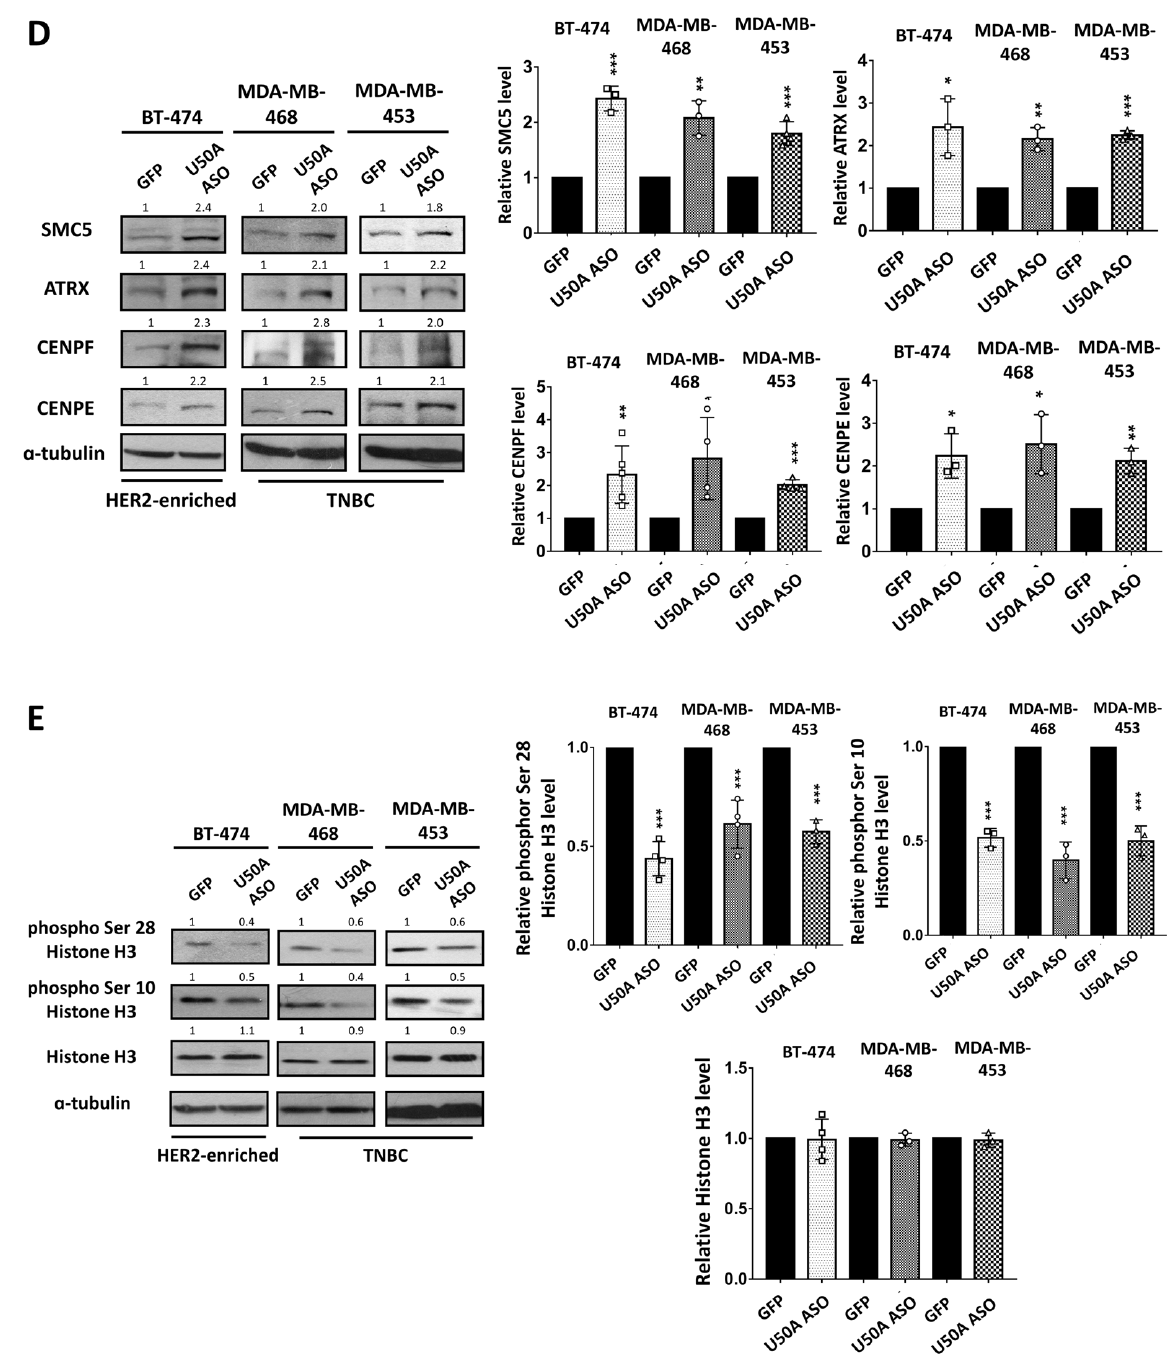
Figure 3. Mitosis-related genes regulated by U50A. ( A ) Validated fold change of CENPE/F, ATRX, and SMC5 in U50A- overexpressing MCF-7 cells. Data are represented as the mean ± SD ( n ≥ 3). *** p < 0.001. Protein expression of the selected targets in U50A-overexpressing ( B ) and U50A-inhibiting ( D ) breast cancer cell lines. Mitotic markers in U50A- overexpressing ( C ) and U50A-inhibiting ( E ) breast cancer cell lines. Bar chart were three independently repeated data quantitated by Image J. Cells were harvested and subjected to real-time quantitative PCR ( A ) and Western blotting ( B – E ). * p < 0.05, ** p < 0.01, *** p < 0.001. The full Western Blots images can be found in Figure